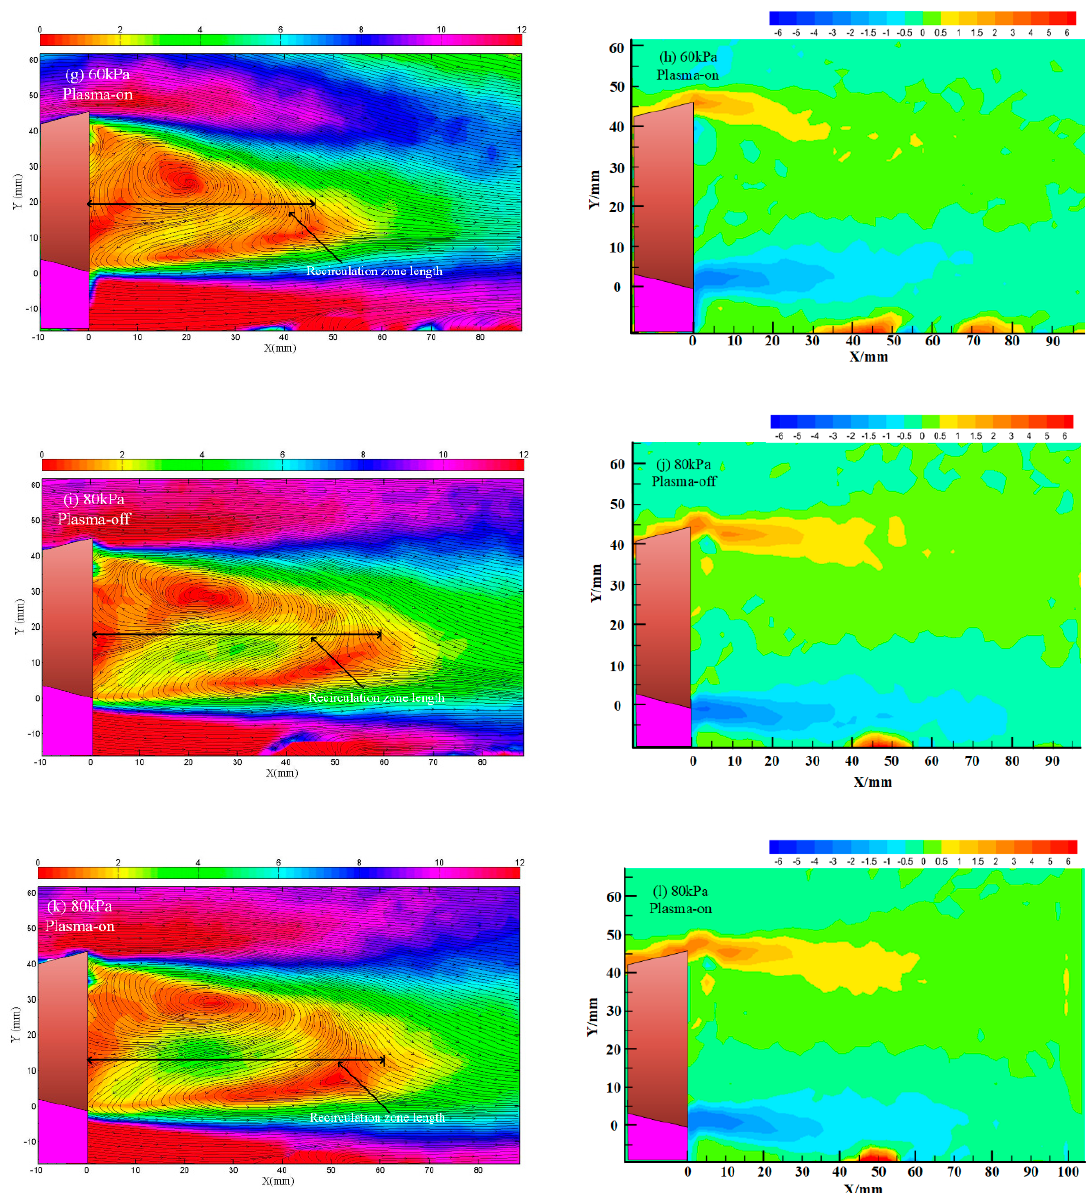
Figure 18. Time-averaged flow structures ( left ) and vorticity contours ( right ) of the flame-holder wake at different pressures with plasma on or off, ( a , b ) 40 kPa with plasma off, ( c , d ) 40 kPa with plasma on, ( e , f ) 60 kPa with plasma off, ( g , h ) 60 kPa with plasma on, ( i , j ) 80 kPa with plasma off, ( k , l ) 80 kPa with plasma on.